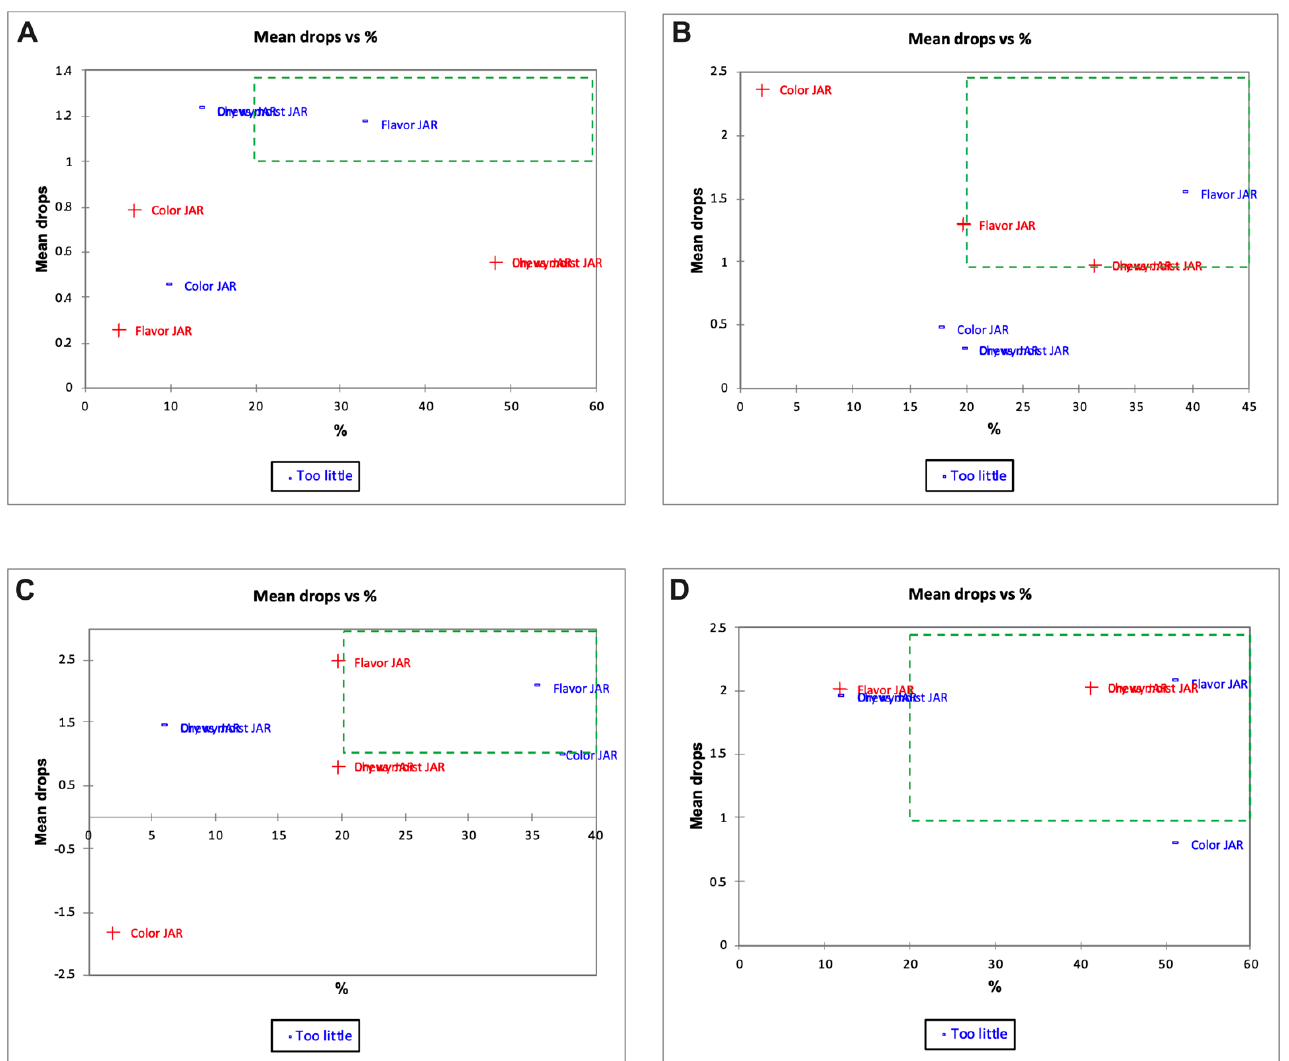
Figure 12. Penalty analysis of day 21 samples (mean drops vs. percent panelist) for Indian flat bread prepared from ( A ) control wheat flour (WF); ( B ) whole wheat flour + encapsulated 17.5 mg iron (EC50); ( C ) whole wheat flour + encapsulated 35 mg iron (EC100); and ( D ) whole wheat flour + color ‐ masked 17.5 mg iron (CM50); n = 51.